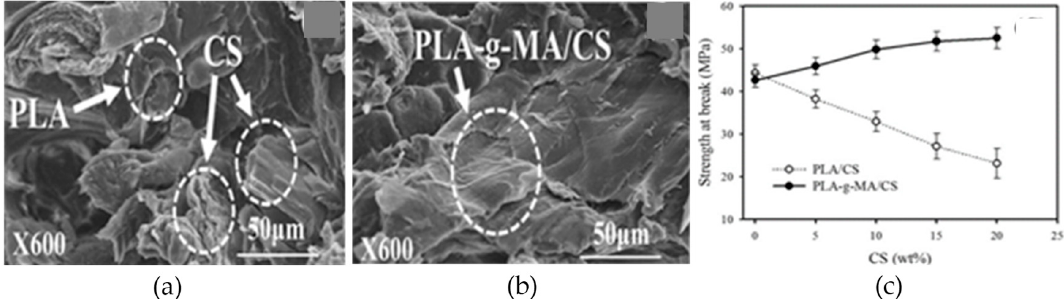
Figure 17. Scanning electron microscopy (SEM) images showing the distribution and wetting of CS ( a ) PLA / CS (10 wt%); ( b ) PLA-g-MA / CS (10 wt%) composites; and ( c ) e ff ect of CS content on the tensile in ( a ) PLA/CS (10 wt%); ( b ) PLA-g-MA/CS (10 wt%) composites; and ( c ) effect of CS content on the strength at failure for PLA / CS and PLA-g-MA / CS composites. Adapted from [173], with permission tensile strength at failure for PLA/CS and PLA-g-MA/CS composites. Adapted from [173], with from © 2016 permission from © 2016 Elsevier .